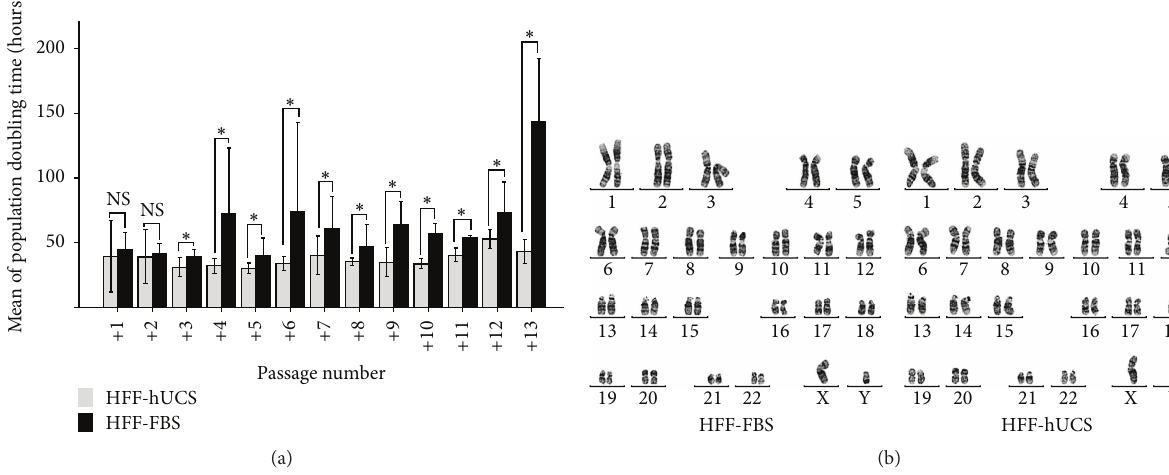
Figure 2: Effect of serum supplementation on cell proliferation and karyotype stability of human foreskin fibroblasts. The cell proliferation of human foreskin fibroblasts (HFFs) was evaluated by determination of their population doubling time (PDT). The ability of HFFs to maintain their normal karyotype was assessed by the G-banding method. The PDT of HFFs cultured in the media containing human cord blood- derived serum (hUCS; HFF-hUCS) and fetal bovine serum (FBS; HFF-FBS) from p4 + 1 to p4 + 13 were determined. The HFF-hUCS from p4 + 3 to p4 + 13 displayed a significantly shorter ( 𝑃 < 0.05 ) PDT than HFF-FBS (a). The karyotype analysis of HFF-FBS and HFF-hUCS demonstrated that both HFFs cultured in hUCS- or FBS-containing media maintained a normal 46,XY karyotype after prolonged culture (b). Error bars represent the standard error of mean (SEM). HFF = human foreskin fibroblasts, FBS = fetal bovine serum, hUCS = human cord blood-derived serum, and NS = not significant. Scale bars = 200 𝜇 m, ∗ 𝑃 < 0.05 .